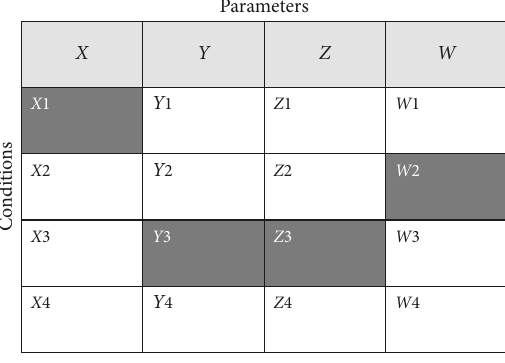
Figure 1: Scenario-planning